Question: What does this figure show? Answer in one sentence.
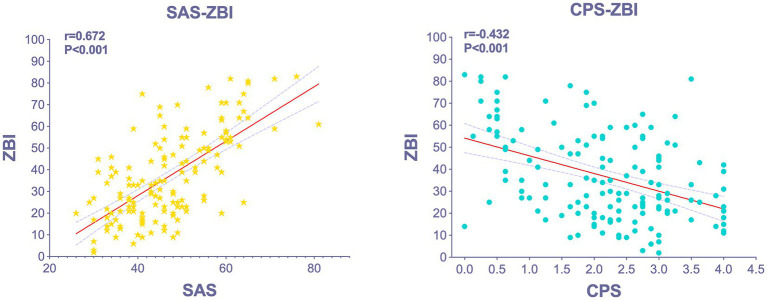
Answer: Pearson correlation analysis of caregiver anxiety level (SAS), caregiver preparedness (CPS), and caregiver burden (ZBI); r = −0.432 (CPS vs. ZBI), p < 0.001; r = 0.672 (SAS vs. ZBI), p < 0.001.